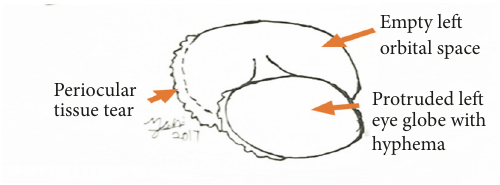
Figure 2: Schematic diagram of the ocular trauma.